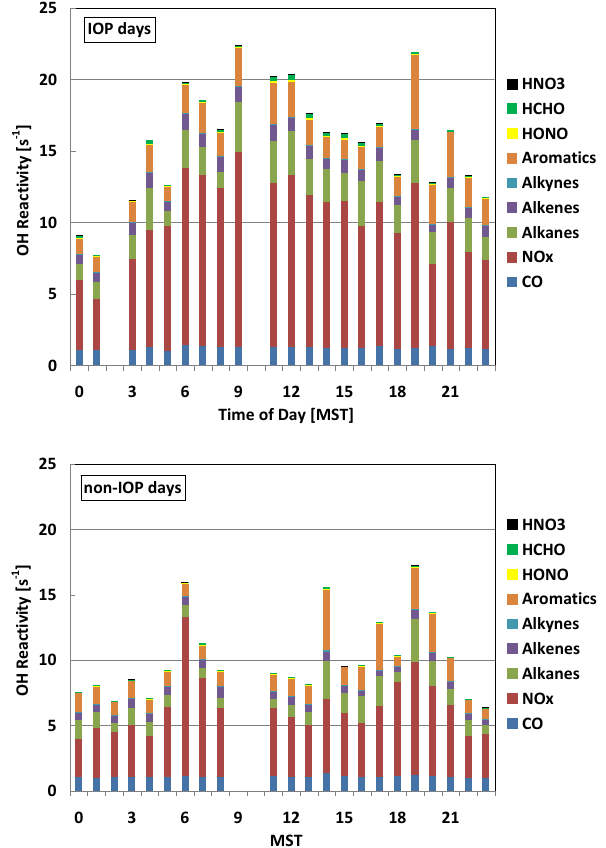
Figure 11. OH reactivity on IOP days (top) and non-IOP days (bot- tom). Speciated NMHC, NO x , and CO data from the Boulder South Road